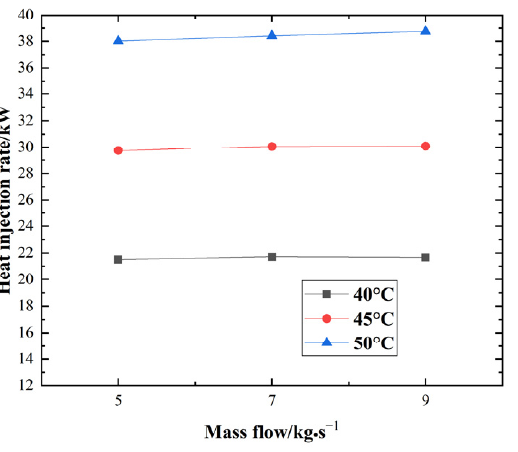
Figure 8. Heat injection rate of the novel DBHE system under different inlet temperatures.